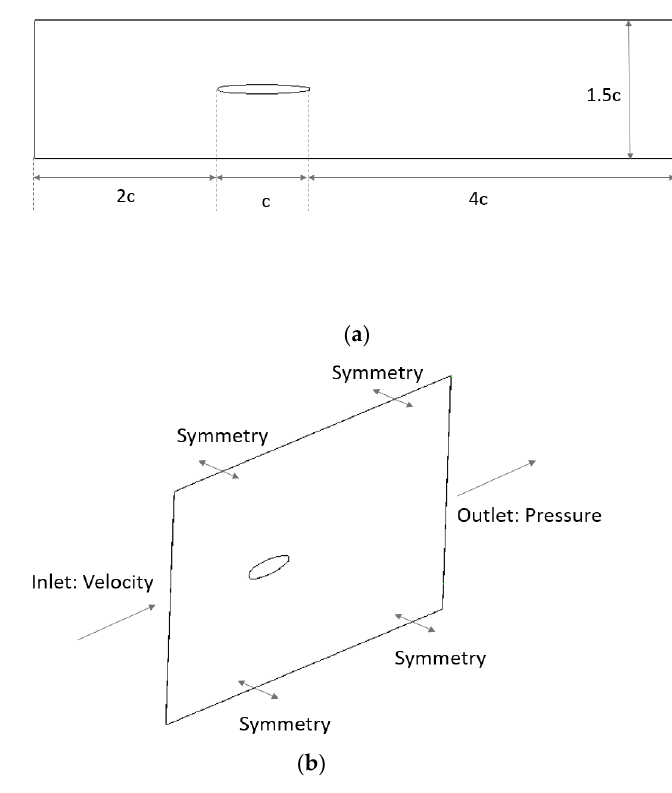
Figure 3. ( a ) Computational domain with dimensions and ( b ) scheme of the boundary conditions.